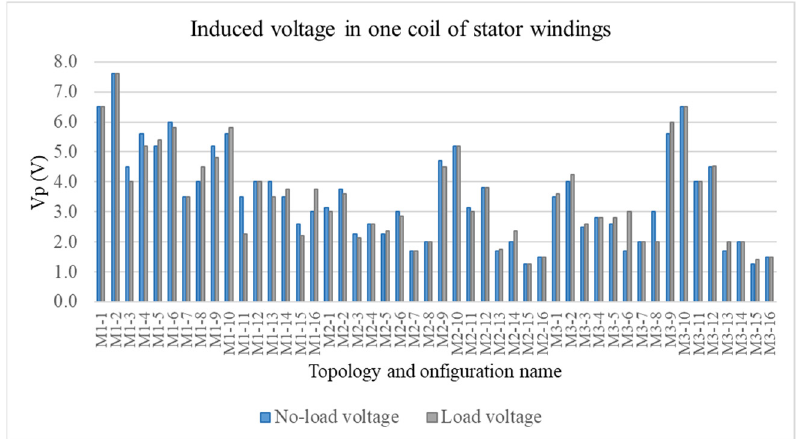
Figure 7. The induced voltage of one phase in the no-load and load tests for different configurations.